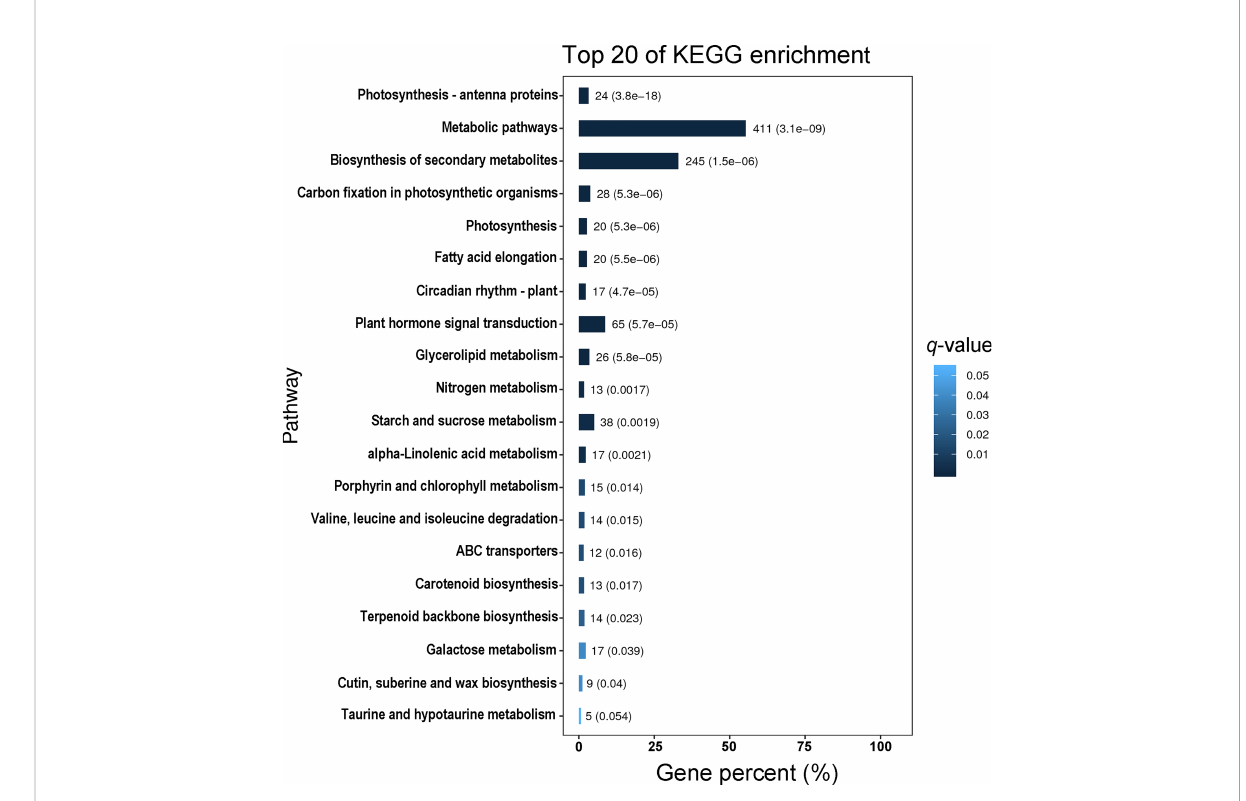
FIGURE 2 The top 20 KEGG pathways enriched with differentially expressed genes (DEGs) in Pyrus betuleafolia leaves after Spodoptera litura